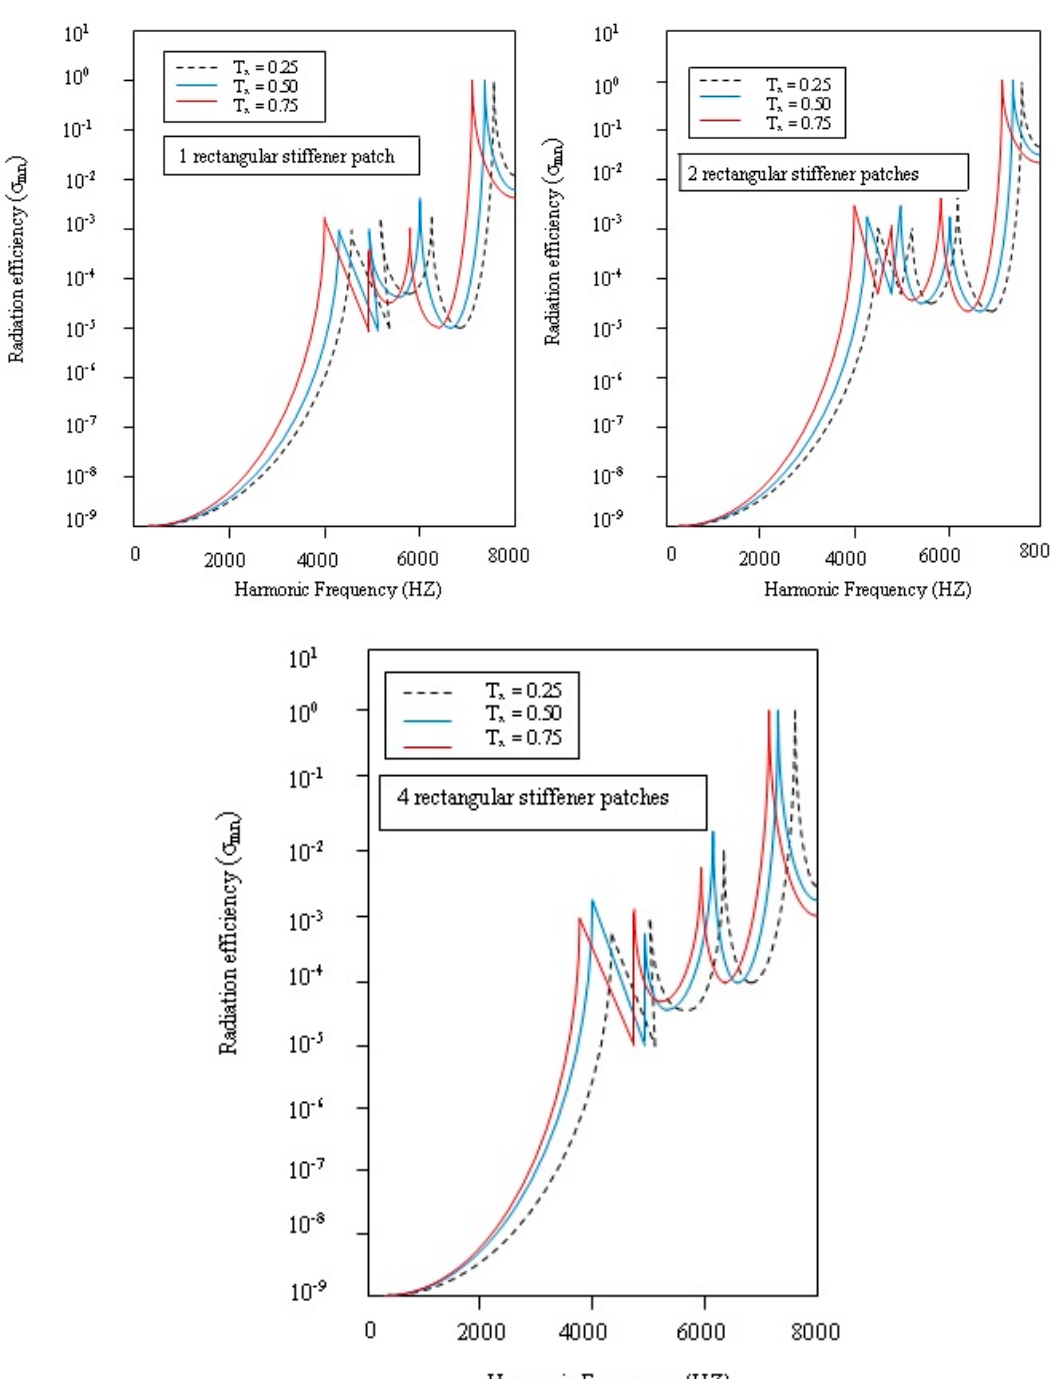
Figure 24. Numerical comparison of radiation efficiency ( σ mn ) for annular plate having parabolically decreasing thickness variations (Case I) with different attachment of (a) 1 rectangular stiffener patch (b) 2 rectangular stiffener patches (c) 4 rectangular stiffener patches for taper ratio T x =0.75.